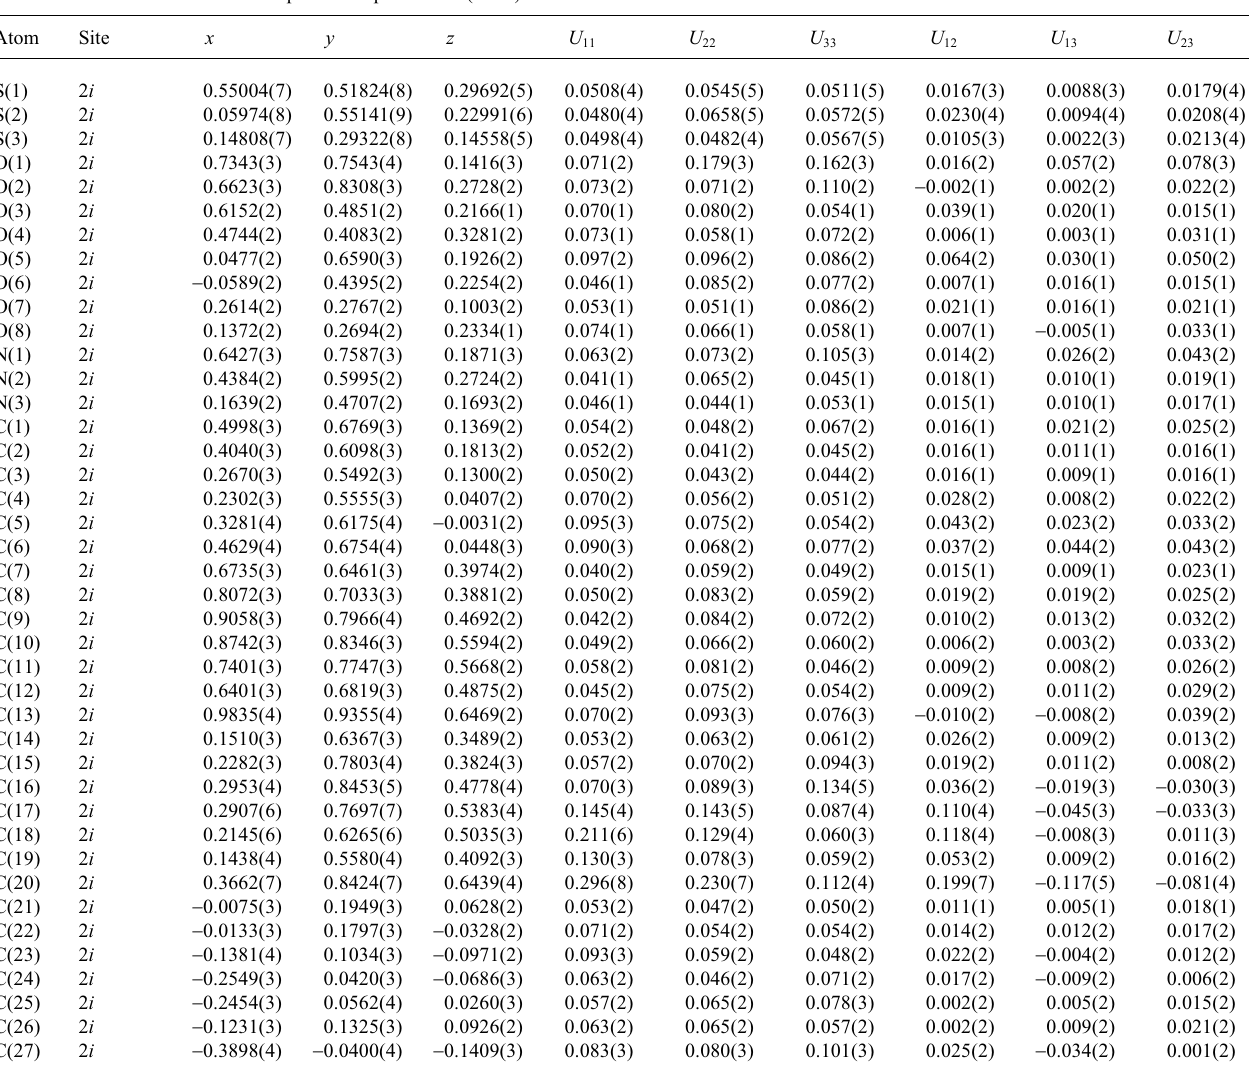
Table 3. Atomic coordinates and displacement parameters (in Å 2 ).